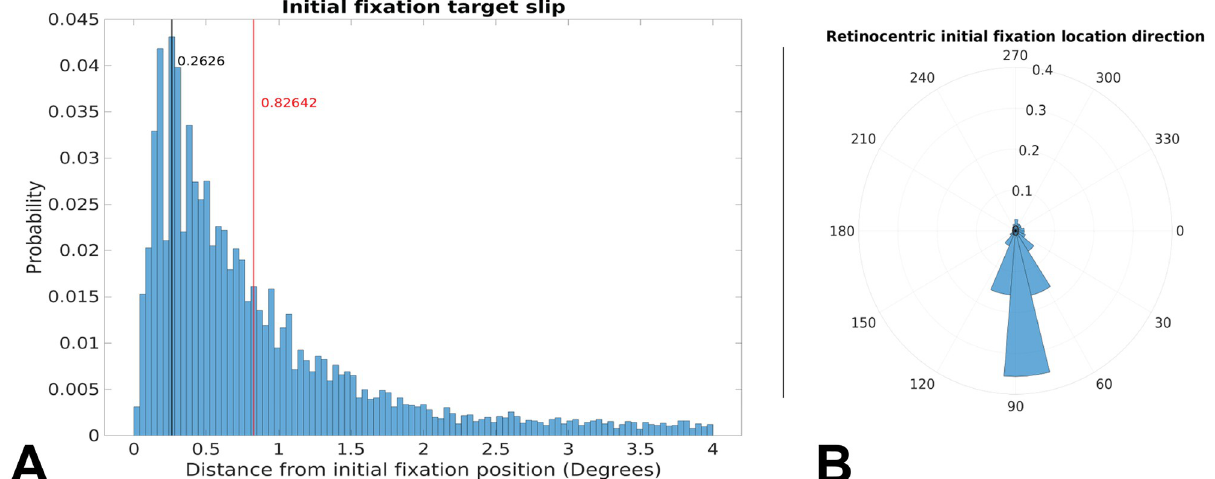
Fig 8. Deviation from initial fixation location over the course of fixation. Initial fixation location is computed and tracked over the course of each fixation, and compared to current fixation for duration of each fixation. Median deviation value is calculated for each fixation. The histogram captures the extent of variability of initially fixated locations relative to the fovea over the course of fixations, with most initially fixated locations never deviating more than 2 degrees of visual angle within the fixation. Long tail of distribution likely arises from erroneously labeled fixations where there are multiple small saccades. Fig 1B. Histogram of directions of retinal slip during a fixation. Most of the values are downward, as expected by a gain of less than